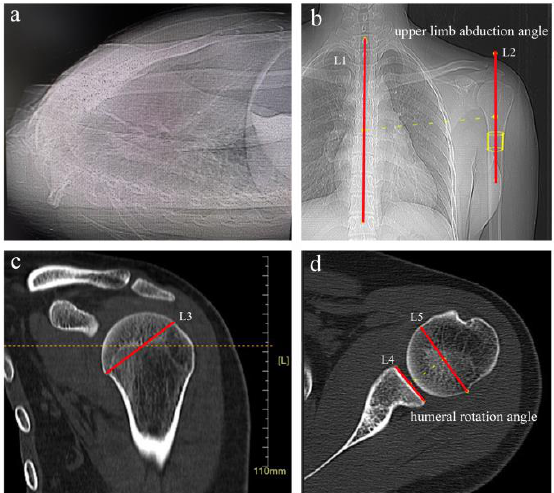
Figure 1. Definition of shoulder measurement axes and angles. ( a ) All subjects were supine in the CT scan tunnel. ( b ) We define the angle between the axis of the proximal humerus (L2) and the line of the spinous process of the spine (L1) as the angle of abduction of the upper limb. ( c ) The level of the center of the humeral head is defined as the level of the median image slice between the most cranial and the most caudal (L3) slice with an identifiable anatomic neck of the proximal humerus. ( d ) We measured the rotation angle of the humerus at the level of the center of the humeral head-the angle between the axis of the humeral head (L5) and the line of bone between the anterior and posterior edges of the glenoid cavity (L4). Patients’ CT scans with upper limb abduction angle (the angle between L1 and L2) and humeral rotation angle (the angle between L4 and L5) greater than or equal to 10 ◦ were excluded because of the association between AHD alteration and upper limb abduction